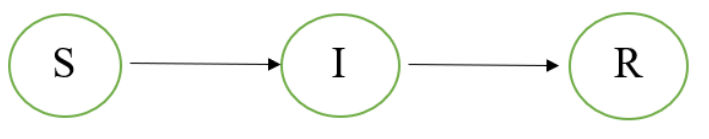
Figure 1. The transition between the components of the SIR